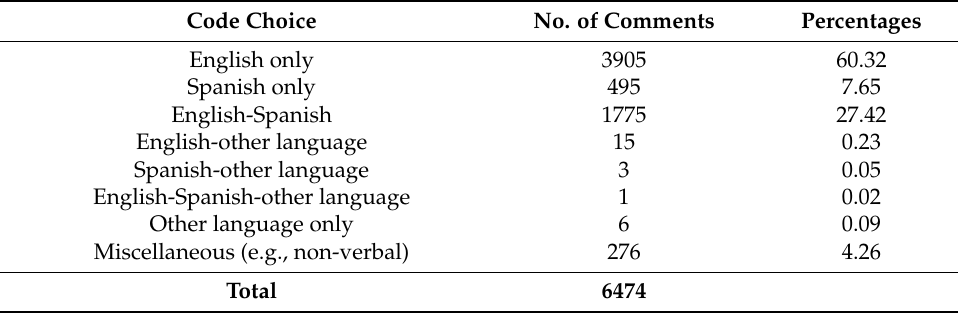
Table 2. Code choice distribution across all comments. Code